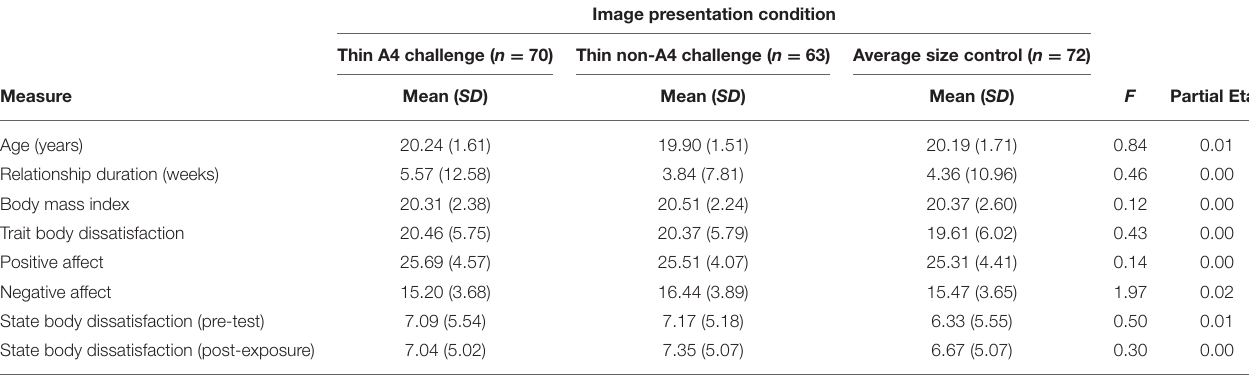
TABLE 4 | Image presentation condition differences on research measures ( N = 205).